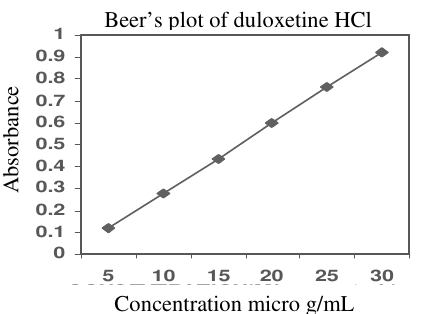
Figure 3 . Standard plot of duloxetine hydrochloride.